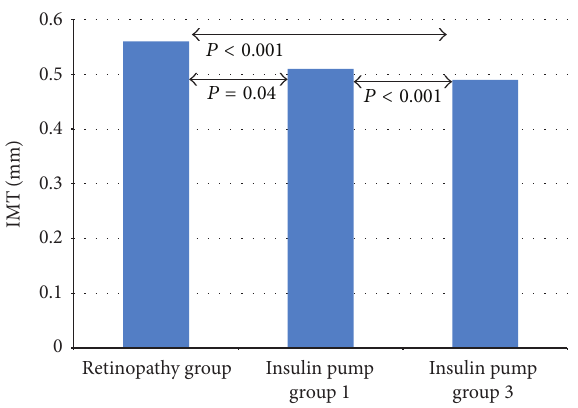
Figure 2: IMT values in the study groups: retinopathy group compared to the pump group before implementation of CSII (insulin pump group 1) and after 6 months (insulin pump group 3).